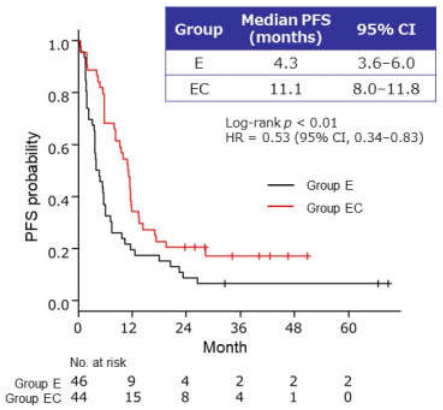
Figure 2. Kaplan–Meier curves of progression-free survival (PFS) in patients who received maintenance therapy with endocrine therapy alone (group E) or endocrine therapy plus capecitabine (group EC) after bevacizumab–paclitaxel in- duction therapy. CI, confidence interval; E, endocrine therapy alone; EC, endocrine therapy plus capecitabine; HR, hazard ratio.